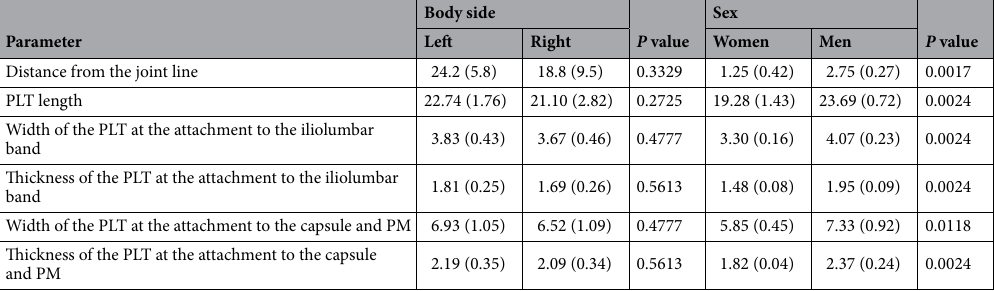
Table 1. A comparison of morphological parameters between body sides and sexes (mm).